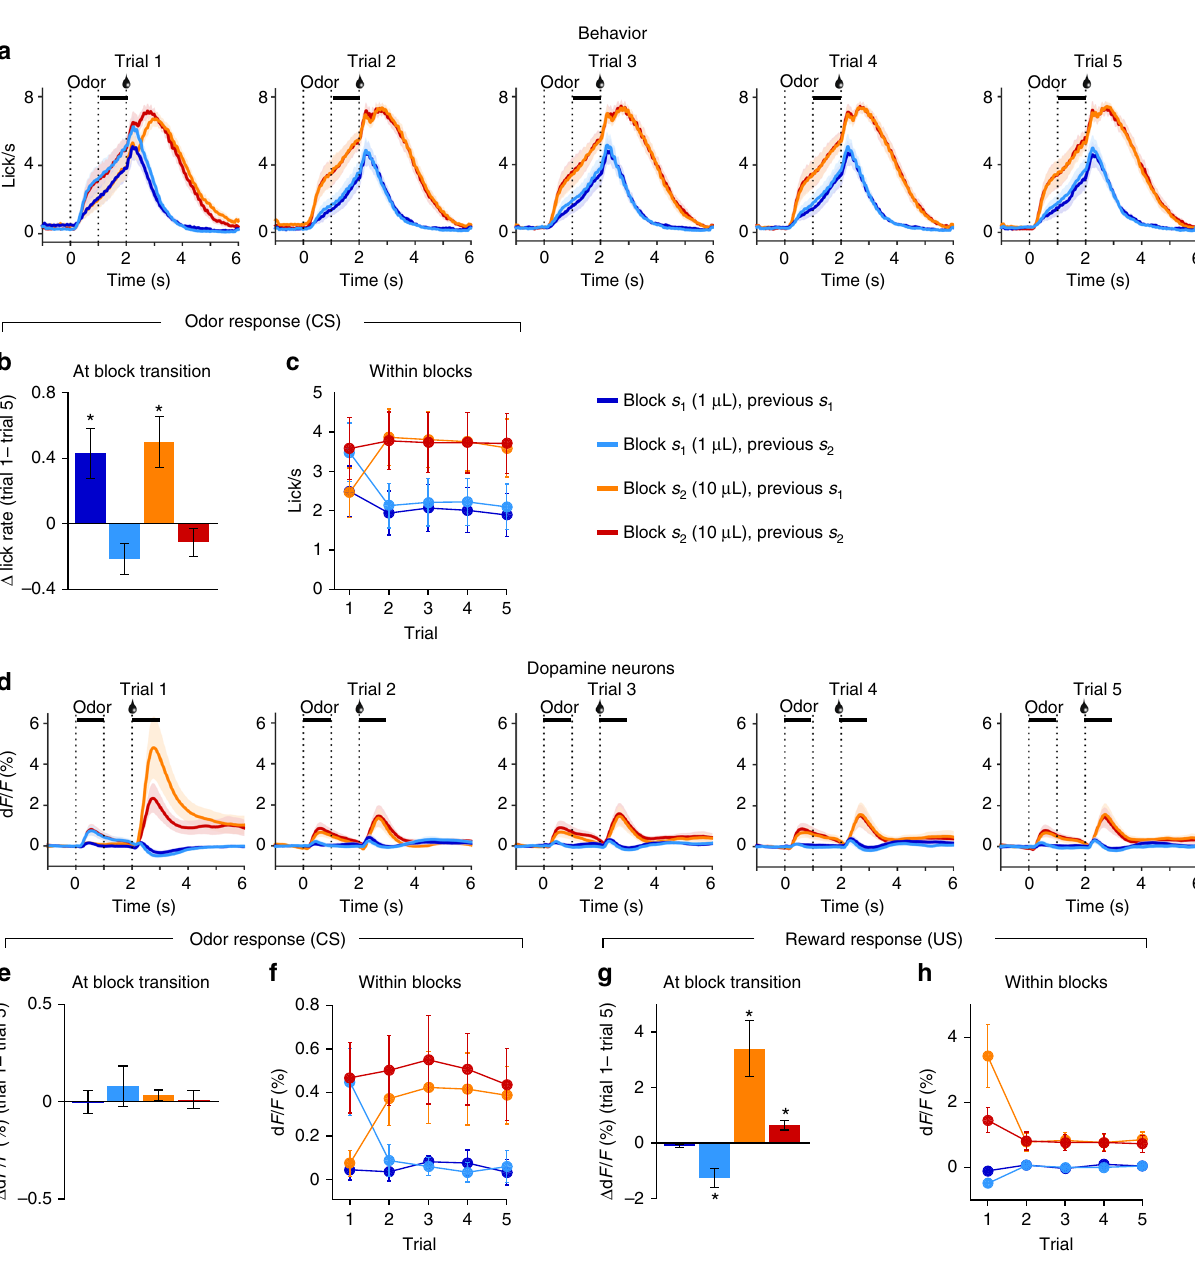
Fig. 2 Behavior and dopamine neuron activity on training blocks s 1 and s 2 . a Licking across the fi ve trials within a block. Anticipatory licking quanti fi cation period during odor to reward delay is indicated by the horizontal black line. b Anticipatory licking at block transition increases when transitioning from the small to the big block. c Anticipatory licking across trials within blocks. Anticipatory licking on trial 1 is similar across all block types then stabilizes at either low or high rates for the following four trials. d Dopamine neuron activity across the fi ve trials within a block. Horizontal black line indicates quanti fi cation period for odor (CS) and reward (US) responses. e Dopamine neurons odor response across block transitions is stable. f Dopamine neurons odor response across trials. Dopamine activity adapts to the current block value within one trial. g Dopamine neurons reward response shows an effect of the current reward and previous block on trial 1. h Dopamine neurons reward response across trials. Dopamine activity reaches stable levels as from trial 2. Data represents mean ± s.e.m. * p < 0.05 for t -test comparing average value to 0. n = 11